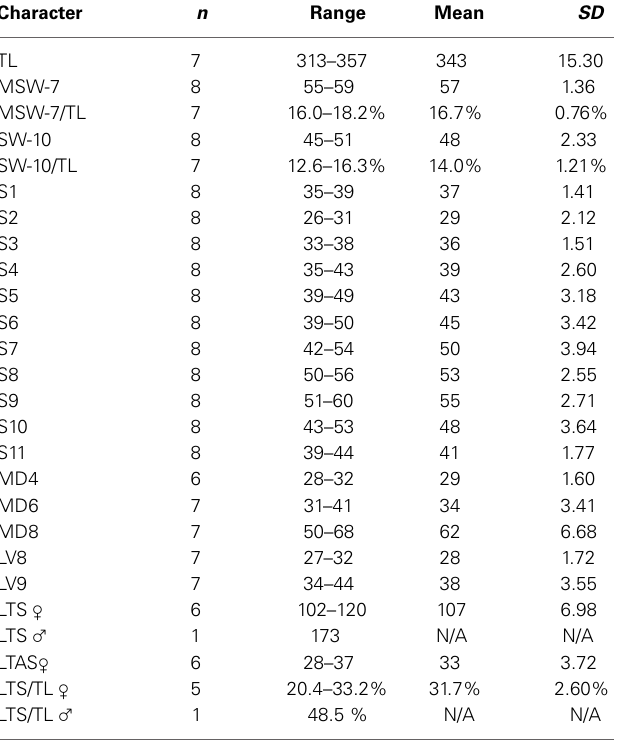
Table 4 | Measurements from light microscopy of adult Echinoderes skipperae sp. nov. (in µ m), including number of measured specimens ( n ), and standard deviation ( SD